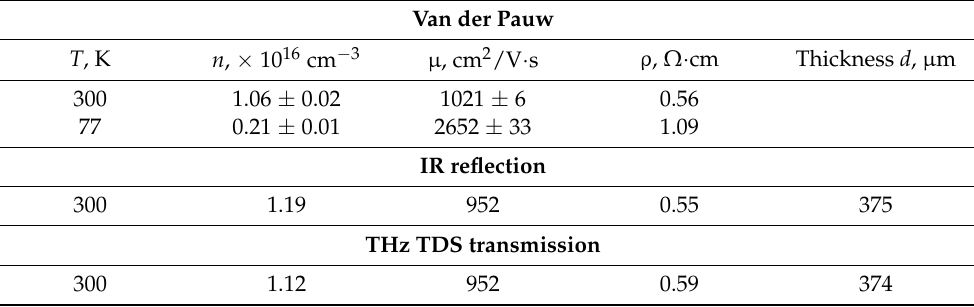
Figure 10. Experimental transmission spectrum measured by THz-TDS (solid red line) and calculated using transfer matrix method and high-frequency Drude conductivity of electrons (dashed black line). Results of fitting are also indicated. Table 2. Summary of parameters of the n -type GaN epilayers measured at low electric field and by optical means.